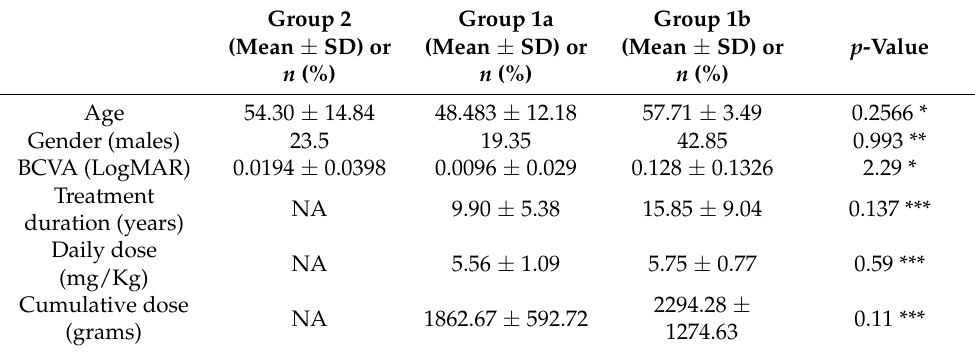
Table 1. Main clinical and demographic features of the study group. Group 1a: eyes of patients under HCQ without retinal toxicity; Group 1b: eyes with toxic HCQ retinopathy; Group 2: eyes of healthy controls; * Kruskal Wallis, ** chi2 test, *** t -test; NA: non-applicable.